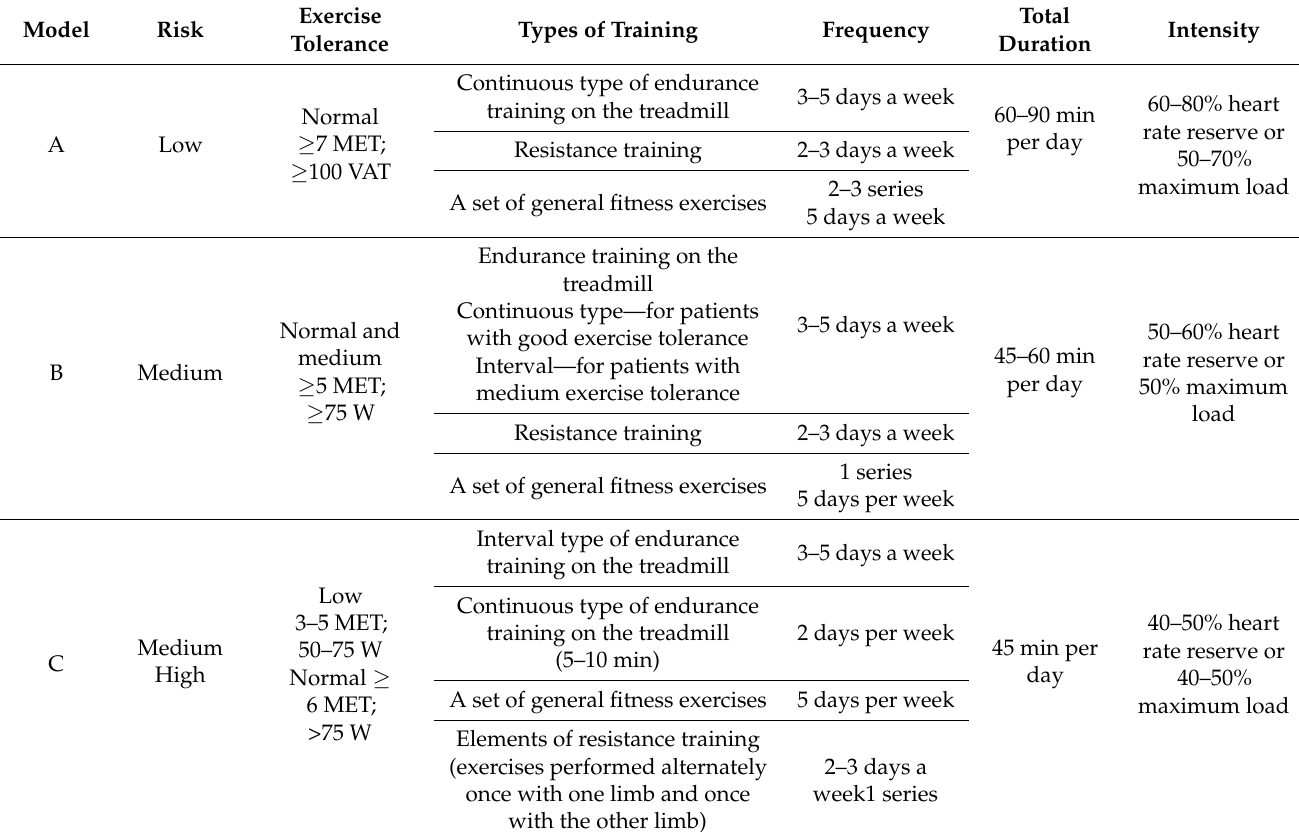
Table 1. Exercise models carried out in cardiological